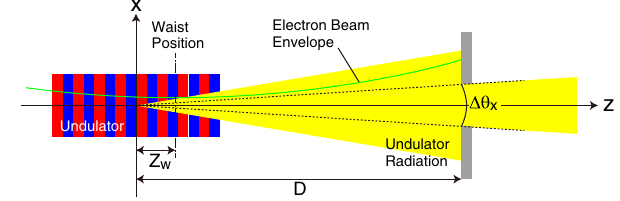
FIG. 1. Coordinate system and parameters to define σ x 0 and Δ θ x